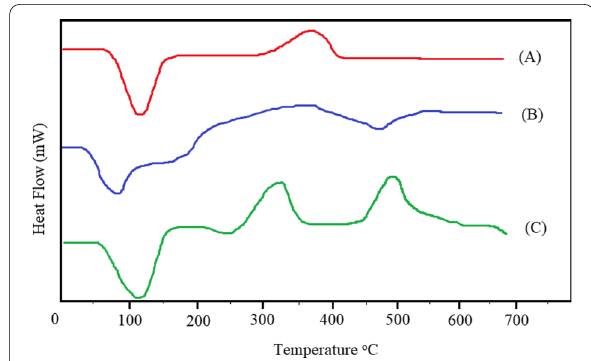
Fig. 5 DSC Study of a Pirfenidone, b Chitosan and c Chitosan nanoparticles of